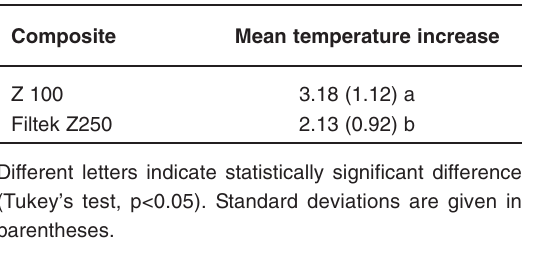
TABLE 3- Mean temperature increase ( 0 C) for Z250 composite resin for each dentin and composite thickness